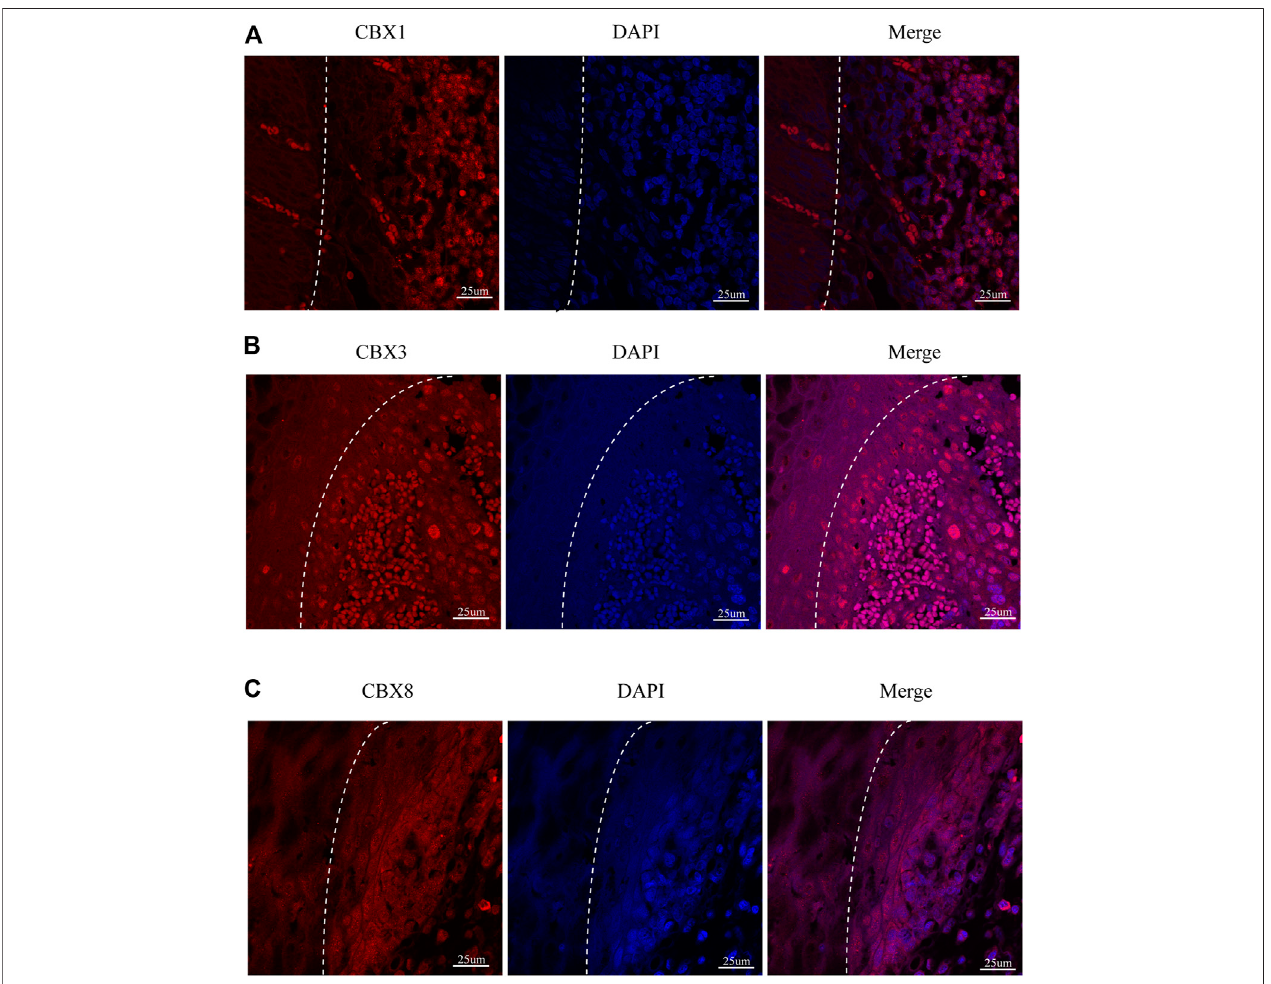
FIGURE 10 | Fluorescence images of paraf fi n-embedded sections of human ESCA and adjacent tissues with confocal microscopy. (A) CBX1 was signi fi cantly higherinESCAtissuesthanthatinprecanceroustissues. (B) CBX3wassigni fi cantlyhigherinESCAtissuesthanthatinprecanceroustissues. (C) CBX8wassigni fi cantly higher in ESCA tissues than that inprecancerous tissues. Thewhitedashed lines separate theprecancerous tissues (on theleft side ofthe fi gure) from the ESCA tissues (on the right side of the fi gure). Scale bars = 25 um. (Magni fi cation 63 ✕ /1.40 oil).